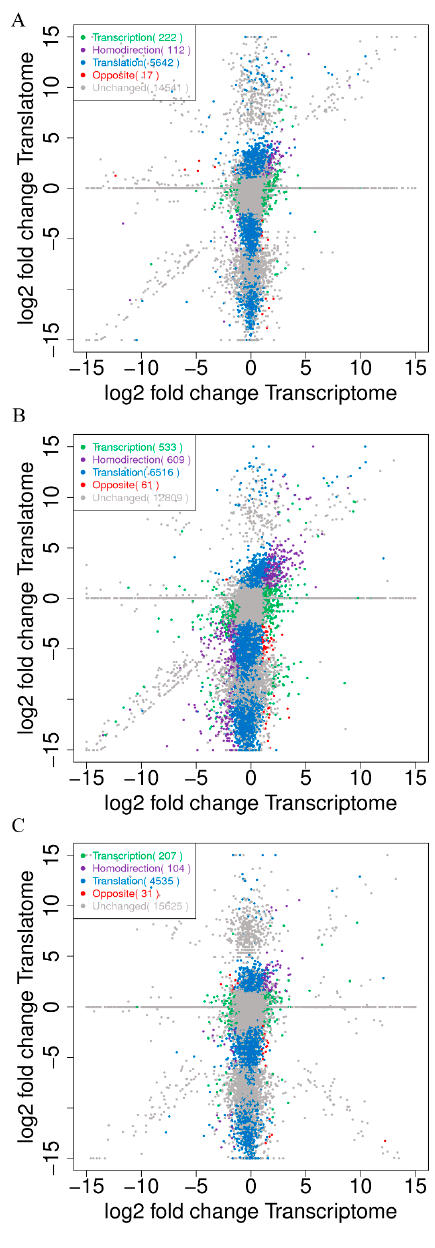
Figure 2. Correlation analysis of the transcriptome and translatome between the TK14, TK15, and TK16 comparison groups of CR tissues. ( A ) Correlation analysis of the transcriptome and transla- tome of the TK14 vs. TK15 comparison group. ( B ) Correlation analysis of the transcriptome and translatome of the TK14 vs. TK16 comparison group. ( C ) Correlation analysis of the transcriptome and translatome of the TK15 vs. TK16 comparison group. The scatter plot of transcribed genes and translated genes in each comparative group were drawn with the X -axis of log2 fold change in the transcriptome and the Y -axis of log2 fold change in the translatome. The gray dots represent unchanged genes that were not differentially expressed at either the transcription and translation levels in CR between the comparison groups. The blue dots represent genes that were only dif- ferentially translated in CR between the comparison groups. The green dots represent genes that were only differential transcribed in CR between the comparison groups. The purple dots represent homodirection genes, which are differentially transcribed genes and differentially translated genes that were upregulated or downregulated in both analyses. The red dots represent opposite genes, which were differentially transcribed genes and differentially translated genes that were upregulated in one analysis and downregulated in the